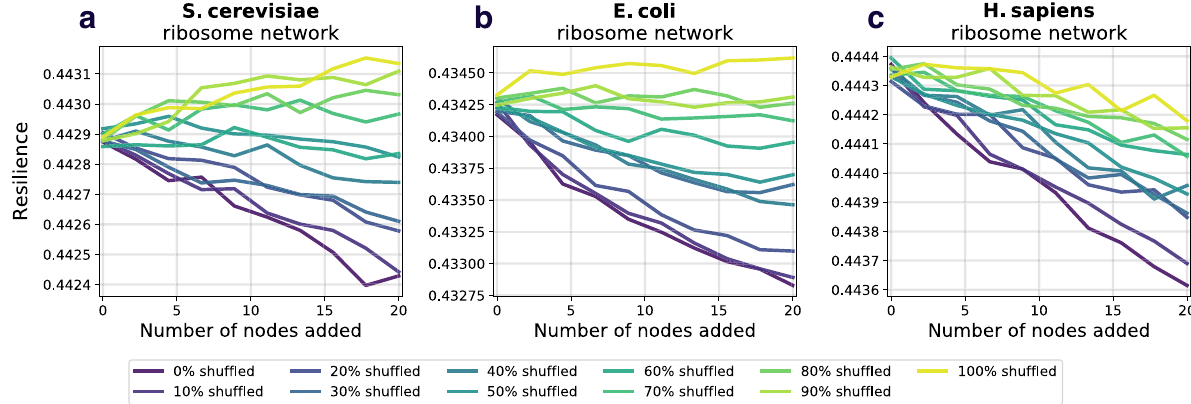
Fig. 6 Prospective resilience and randomized gene expression. We examine if speci fi c gene expression is driving the high prospective resilience of the expression-based attachment rule or if merely attaching nodes based on a shuf fl ed gene expression distribution could bring about these results. Each new node joins with m = 5 for S. cerevisiae and E. coli , and m = 6 for H. sapiens . These values were selected so that the slope of the prospective resilience would be closest to 0.0 when the gene expression was not shuf fl ed (0% shuf fl ed). See Table 2 for how the correlation between a node ’ s degree and its gene expression changes as noise increases. a Prospective resilience of S. cerevisiae ribosomal network. b Prospective resilience of E. coli ribosomal network. c Prospective resilience of H. sapiens ribosomal network. Notably, we fi nd that the prospective resilience of the networks increases simply by increasing the fraction of nodes with shuf fl ed gene